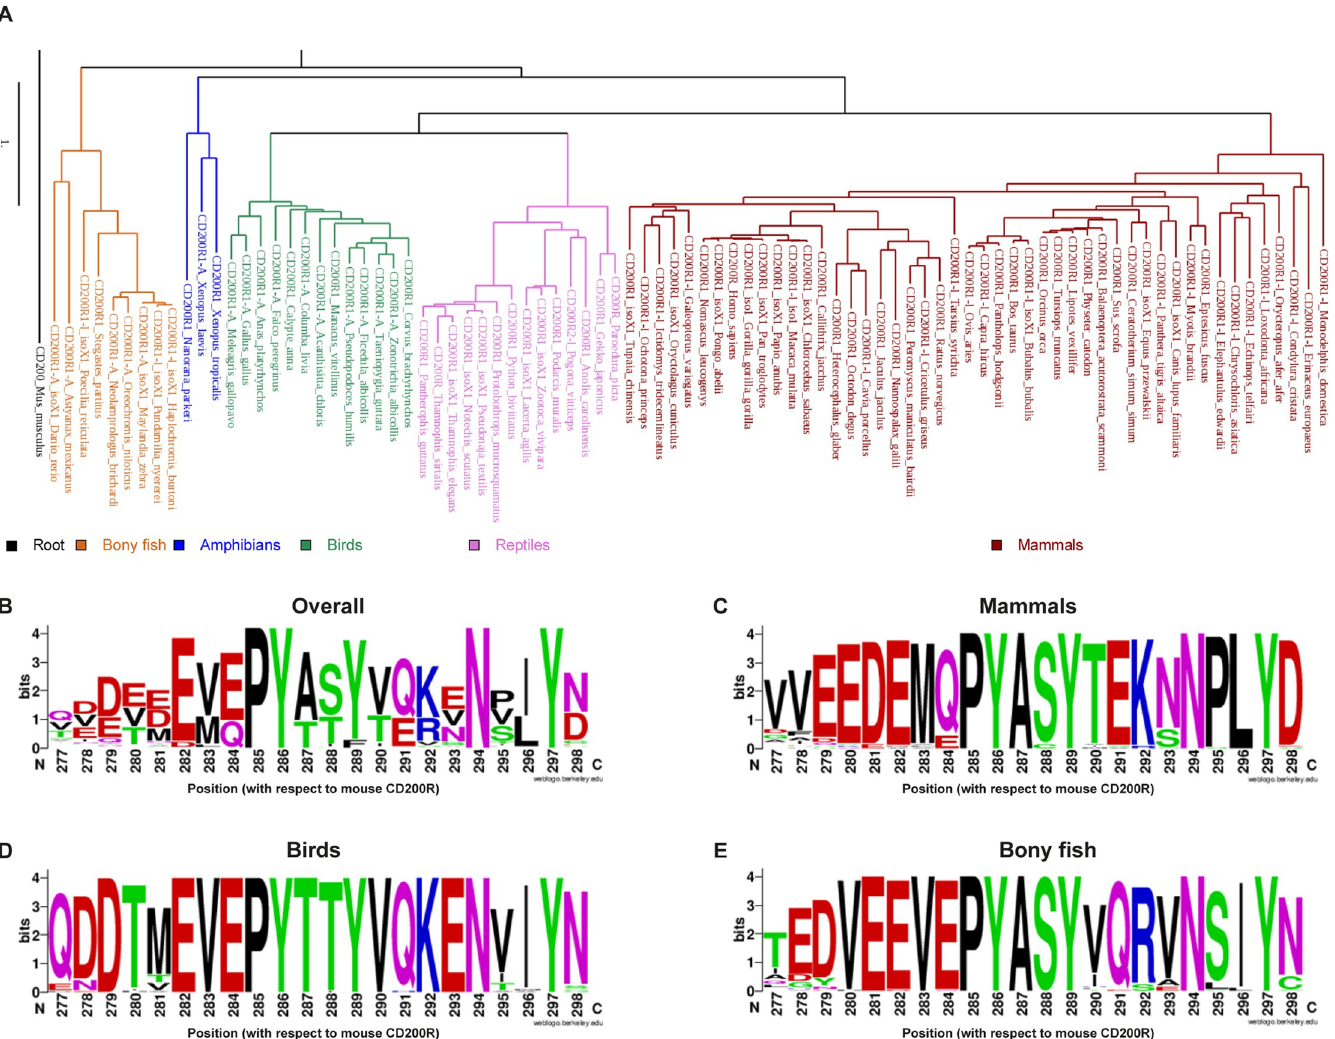
Fig 2. The high conservation of the intracellular domain of CD200R among species is not limited to the NPxY-motif. The NCBI protein BLAST tool identified 179 human CD200R1 homologues amongst all 5 animal classes. A) Phylogenetic analysis of a balanced selection of full CD200R1 homologues. Mouse CD200 sequence was used as an outgroup to root the tree. B) All CD200R sequences identified in A) were plotted in a conservation plot using WebLogo [35]. C-E) Conservation logo’s created by WebLogo [35] per animal class: mammals (C); birds (D); and bony fish (E). Maximal conservation represents 4.2 bits. The height of the amino acid letters shows the frequency of the amino acid on that particular position in the sequence alignment. The amino acids are colored according to the physio-chemical properties of their side chains: polar (green), neutral (purple), basic (blue), acidic (red), or hydrophobic